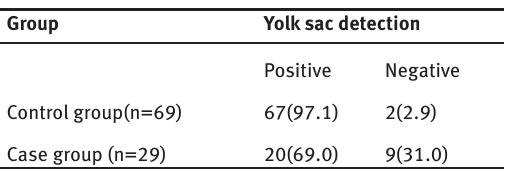
Table 1: Yolk sac detection rate by ultrasonography between control and case groups [n(%)].